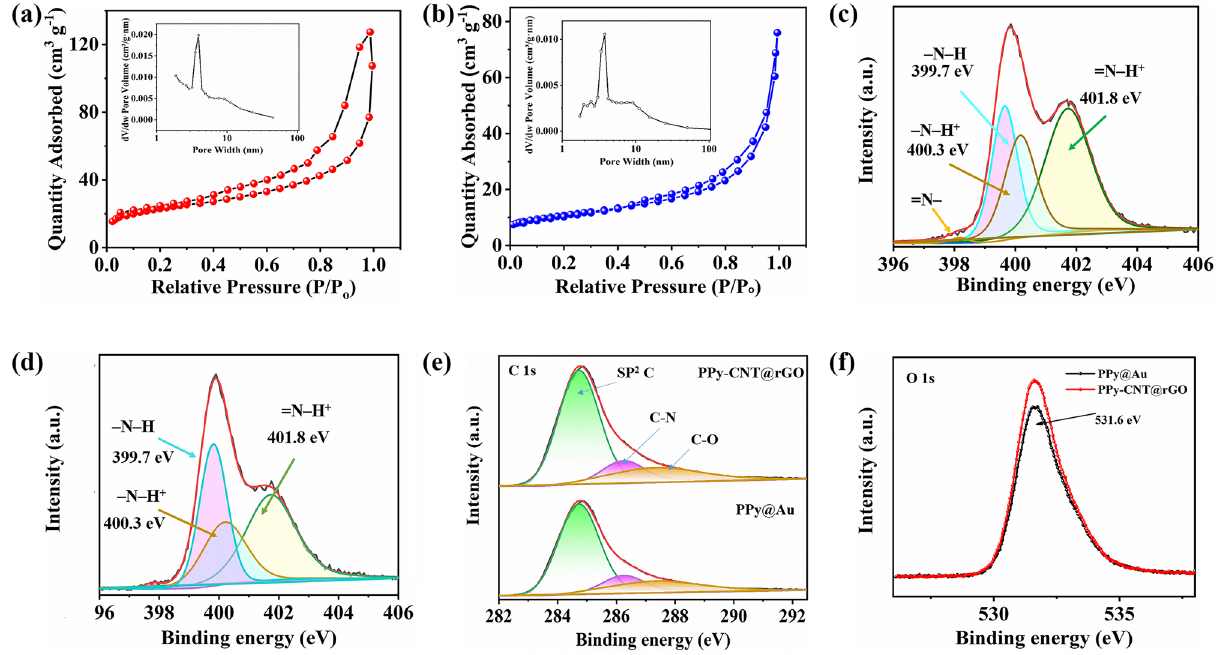
Fig. 3 a, b The nitrogen adsorption–desorption isotherms of PPy-CNT@rGO and pristine PPy. The insets show the corresponding pore size dis-